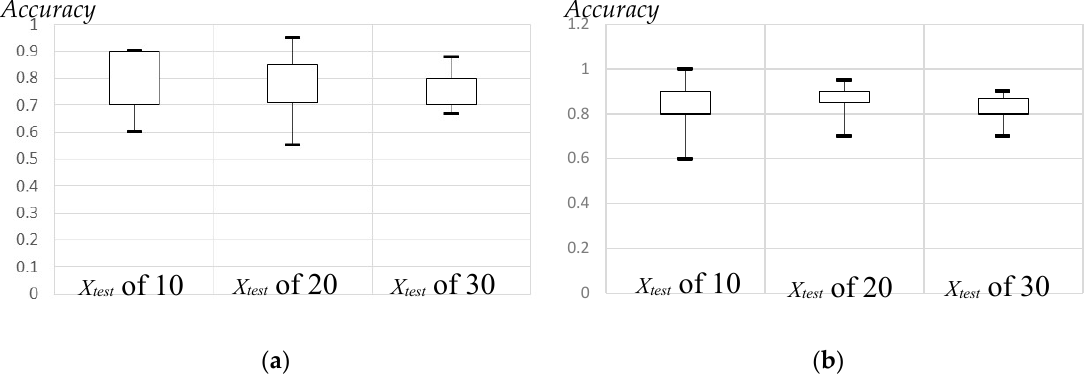
Figure 3. Boxplots of the proposed method with an c = 3. ( a ) LSSVMFS; ( b ) SVMFS.